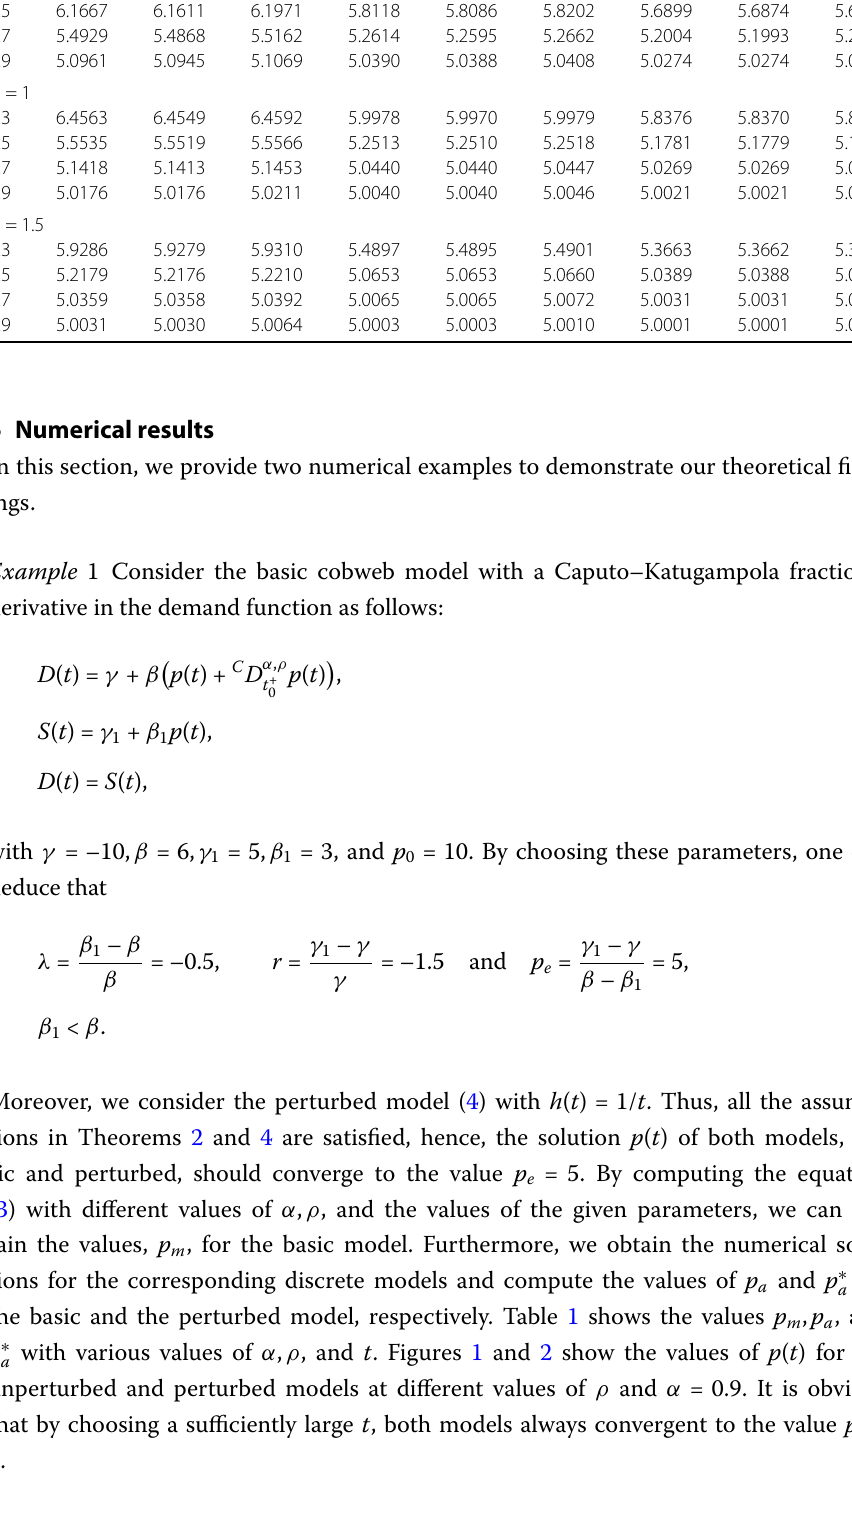
Table 1 The values of p ( t ) for the unperturbed and perturbed model of Example 1 t 100 500 ρ =